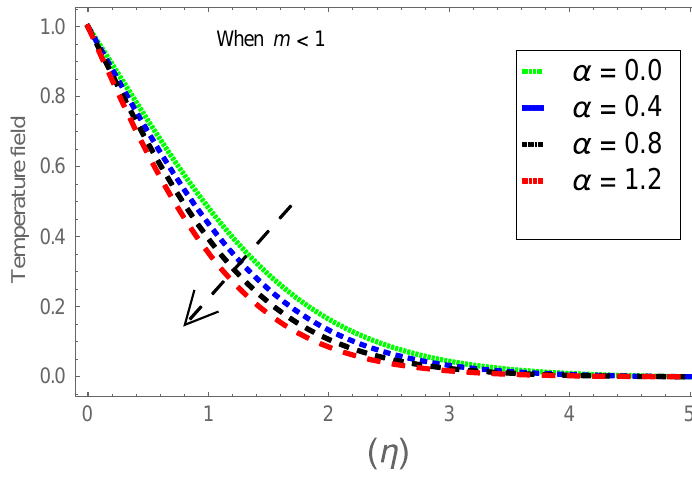
              ( α ) via θ ( η ) via . Figure 18. Consequence of via .